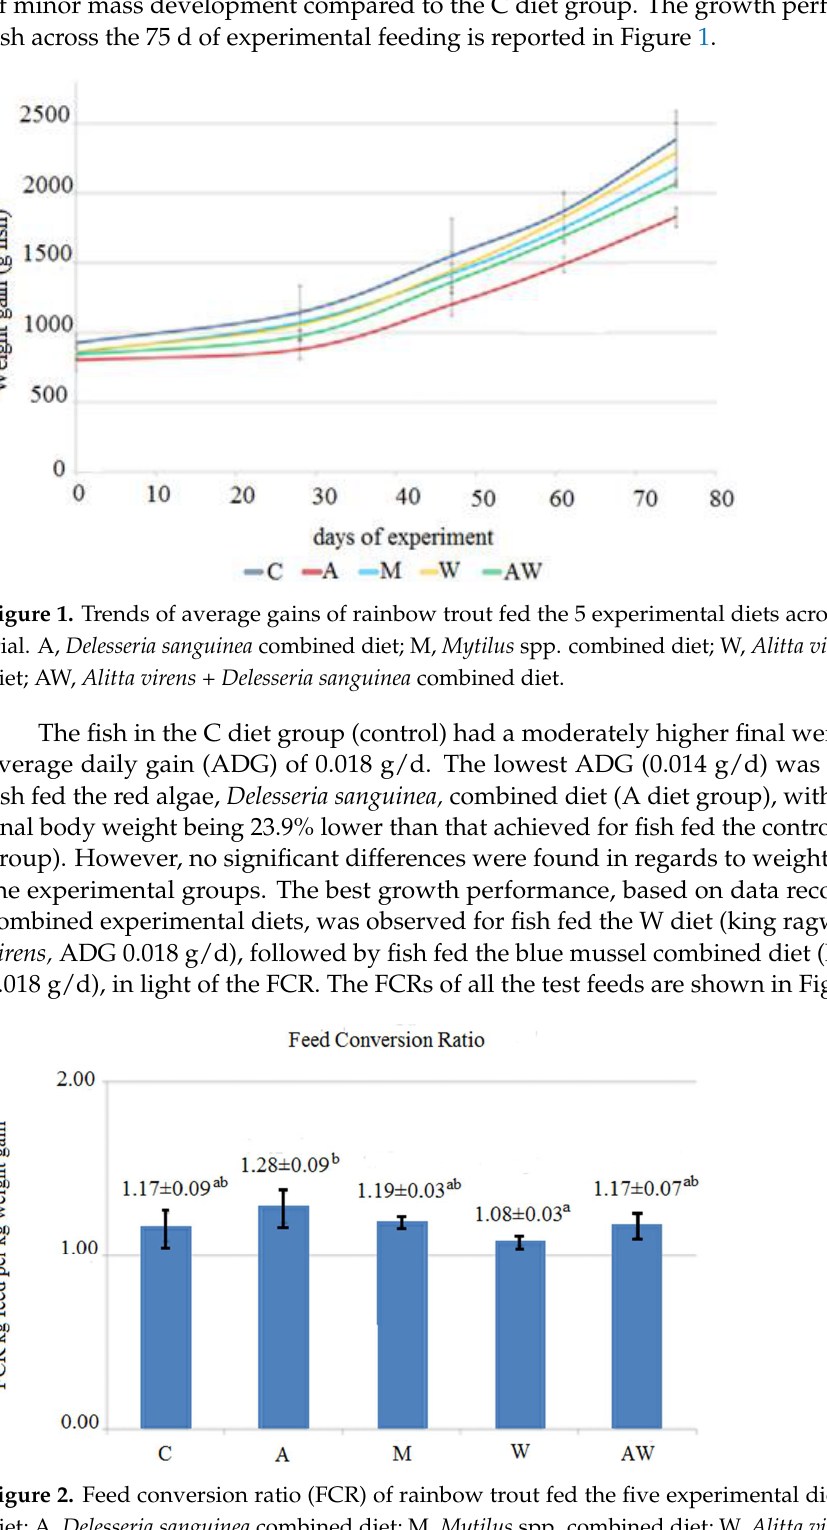
During experimental feeding, rainbow trout from all the groups displayed doubled average gains within 75 d from the start of the experiment. Only the A diet showed a trend of minor mass development compared to the C diet group. The growth performance per fish across the 75 d of experimental feeding is reported in Figure 1. fish across the 75 d of experimental feeding is reported in Figure 1.